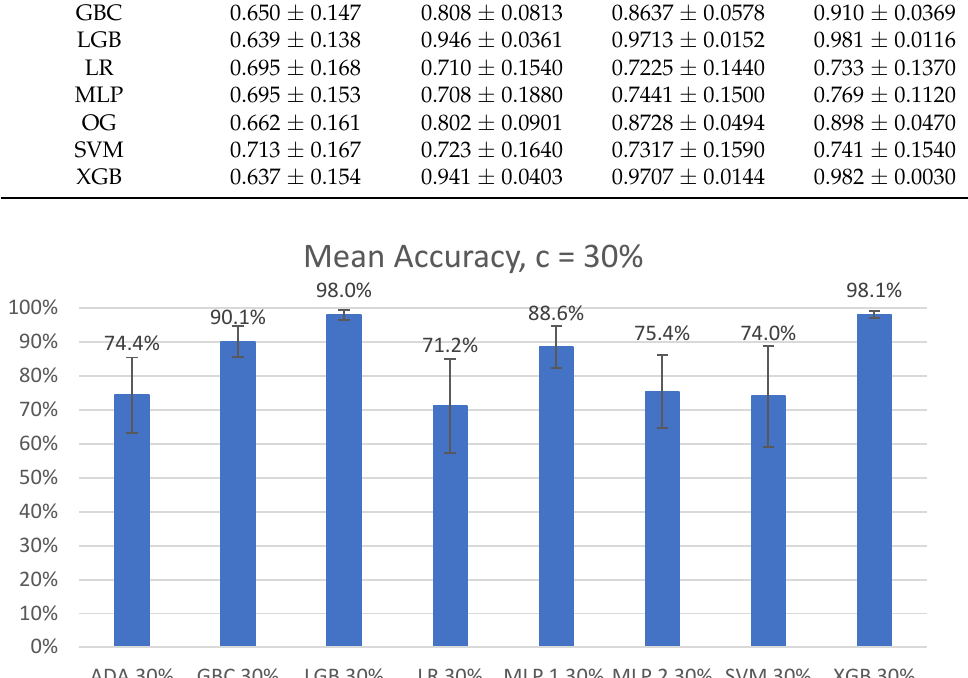
Figure 3. Mean accuracy of left-side lying, supine, or right-side lying classification by model for the incremental learning level c = 30%. Error bars represent standard deviations.